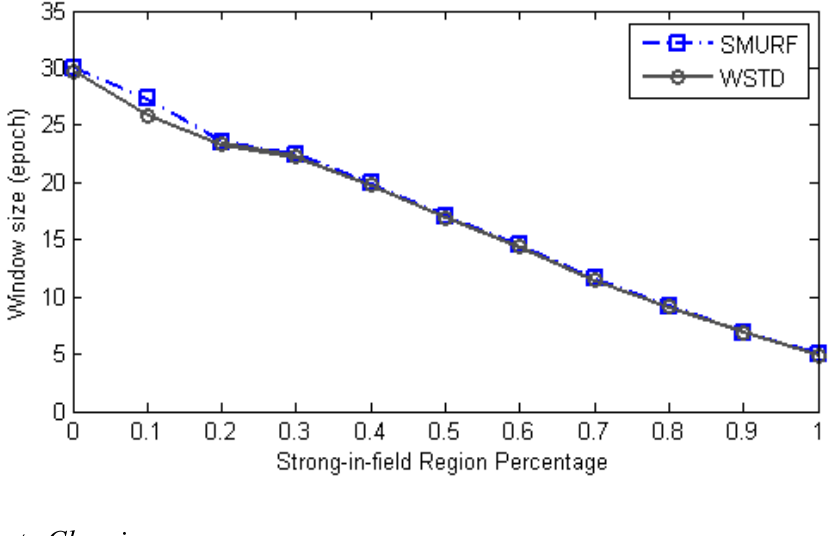
Figure 15. Comparison of WSTD and SMURF schemes’ cleaning window sizes as the environment noise is